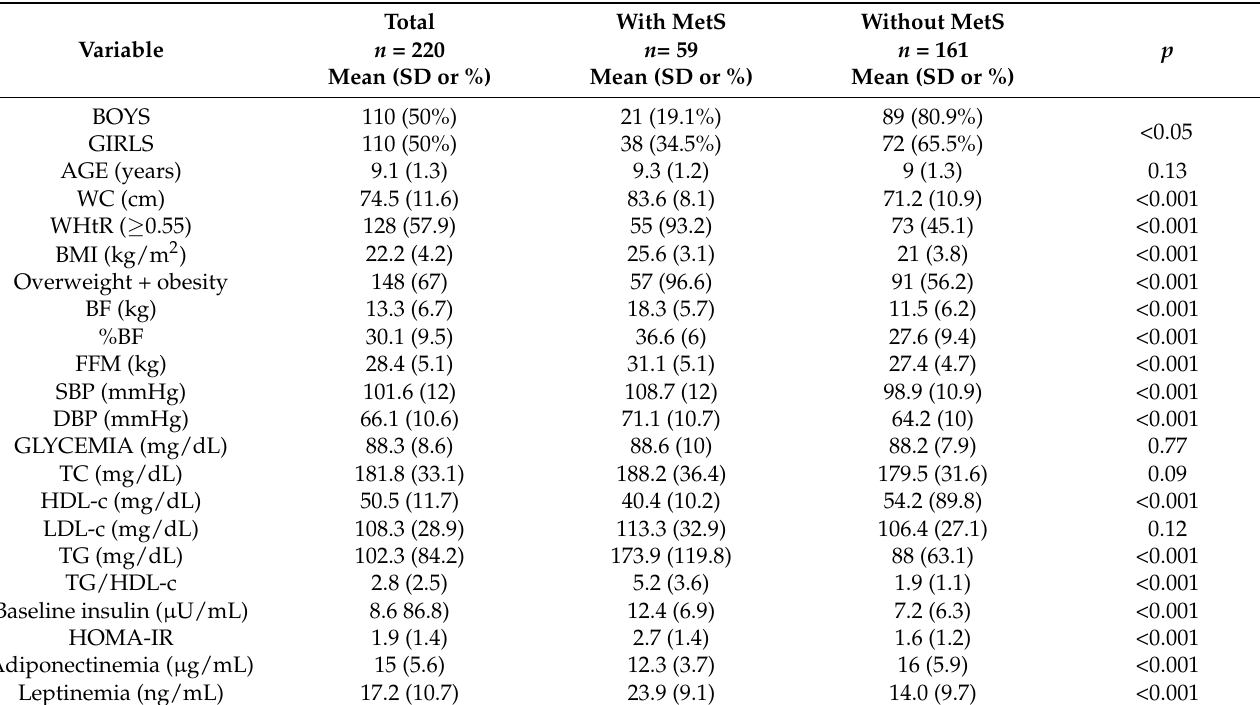
Table 1. Characteristics of the sample according to the presence of